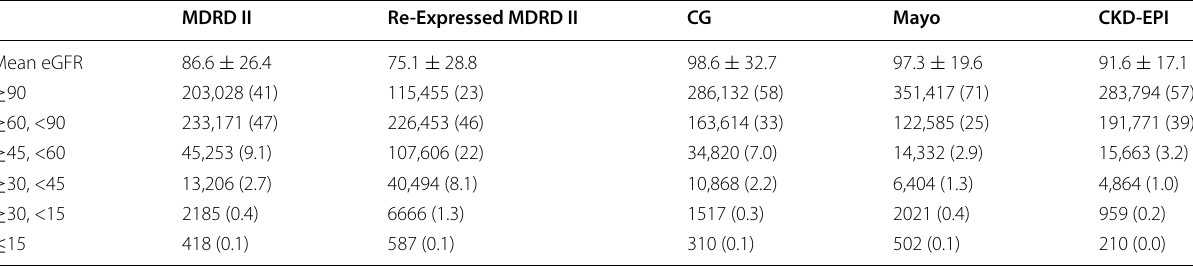
Data are expressed as the number of patients